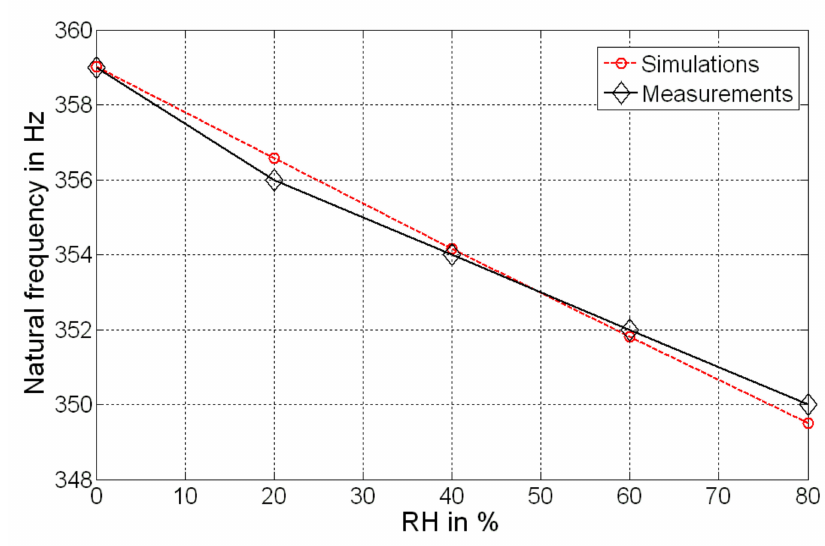
Figure 8. Natural frequency shift as a function of the measurand. A comparison with respect to the simulation through Equation (8) is accomplished.